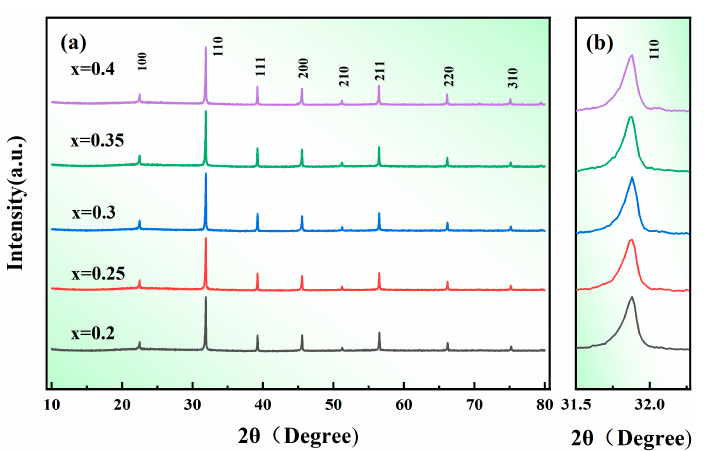
Figure 1. ( a ) XRD spectra (0.4 − x)BF-xBMT-0.6BT ceramics; ( b ) locally magnified (110) diffraction peaks.